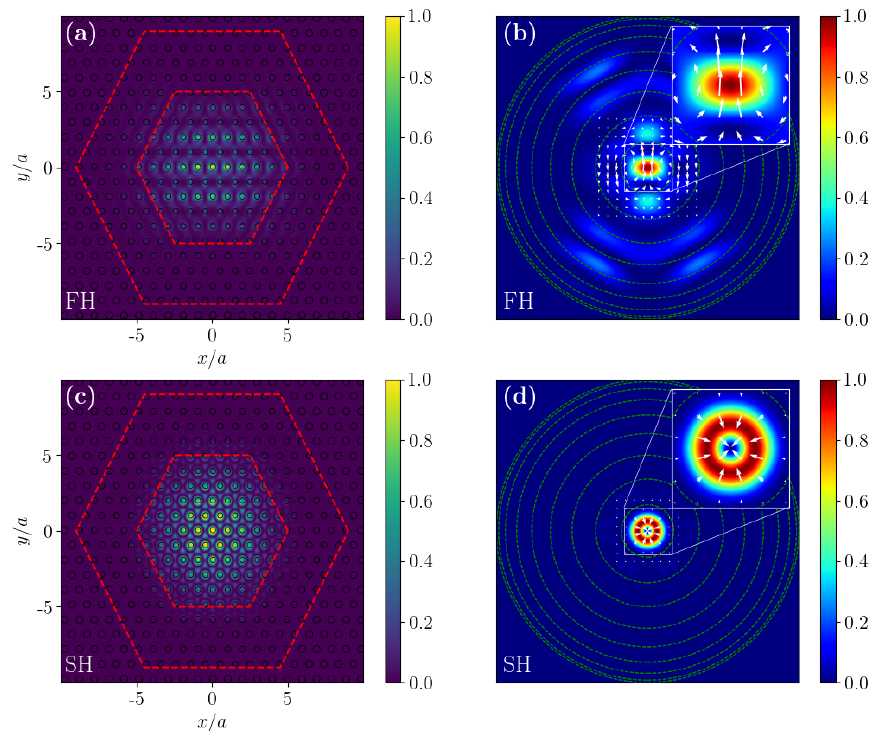
Figure 5. ( a – c ) FH and SH cavity mode intensity profiles at the centre of the slab z = 0. ( b – d ) Colour maps representing the emission intensity profile of the FH and SH cavity modes. Every green circle identifies 10° from the vertical direction of emission with respect the slab plane. The white arrows (cid:0) (cid:1) ( E x ) , E y show the vector field defined by ( (cid:60) (cid:60)